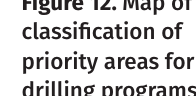
Figure 12. Map of classification of priority areas for drilling